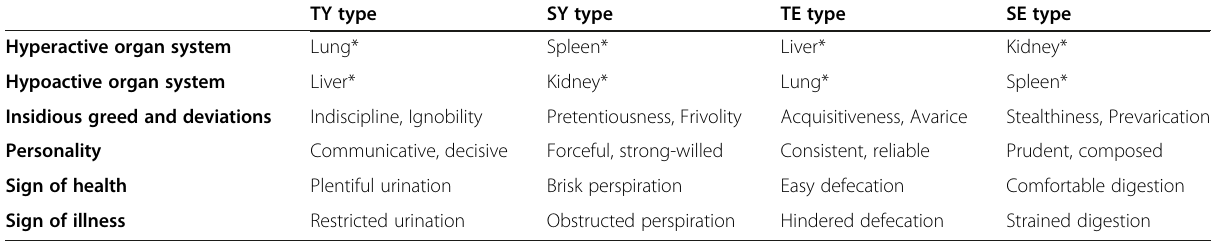
Table 1 General characteristics of the four Sasang constitutional